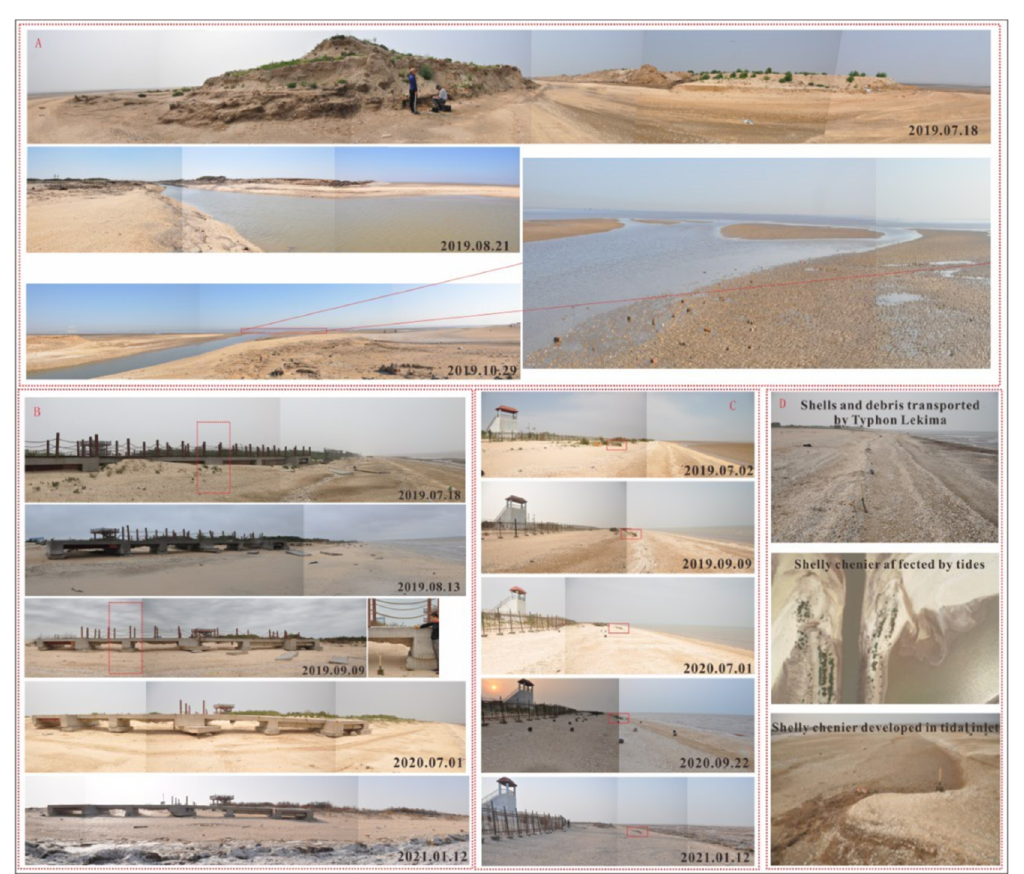
Figure 5. Typical geomorphic changes under the action of normal and typhoon hydrodynamics (Typhoon Lekima: 10–12 August 2019), ( A ): P1, belonging to the tidal channel shelly chenier; ( B ) is point P2 and ( C ) is point P3, which belong to the open shelly chenier; ( D ): Changes in the shelly chenier under the action of Typhoon Lekima and the tidal current.